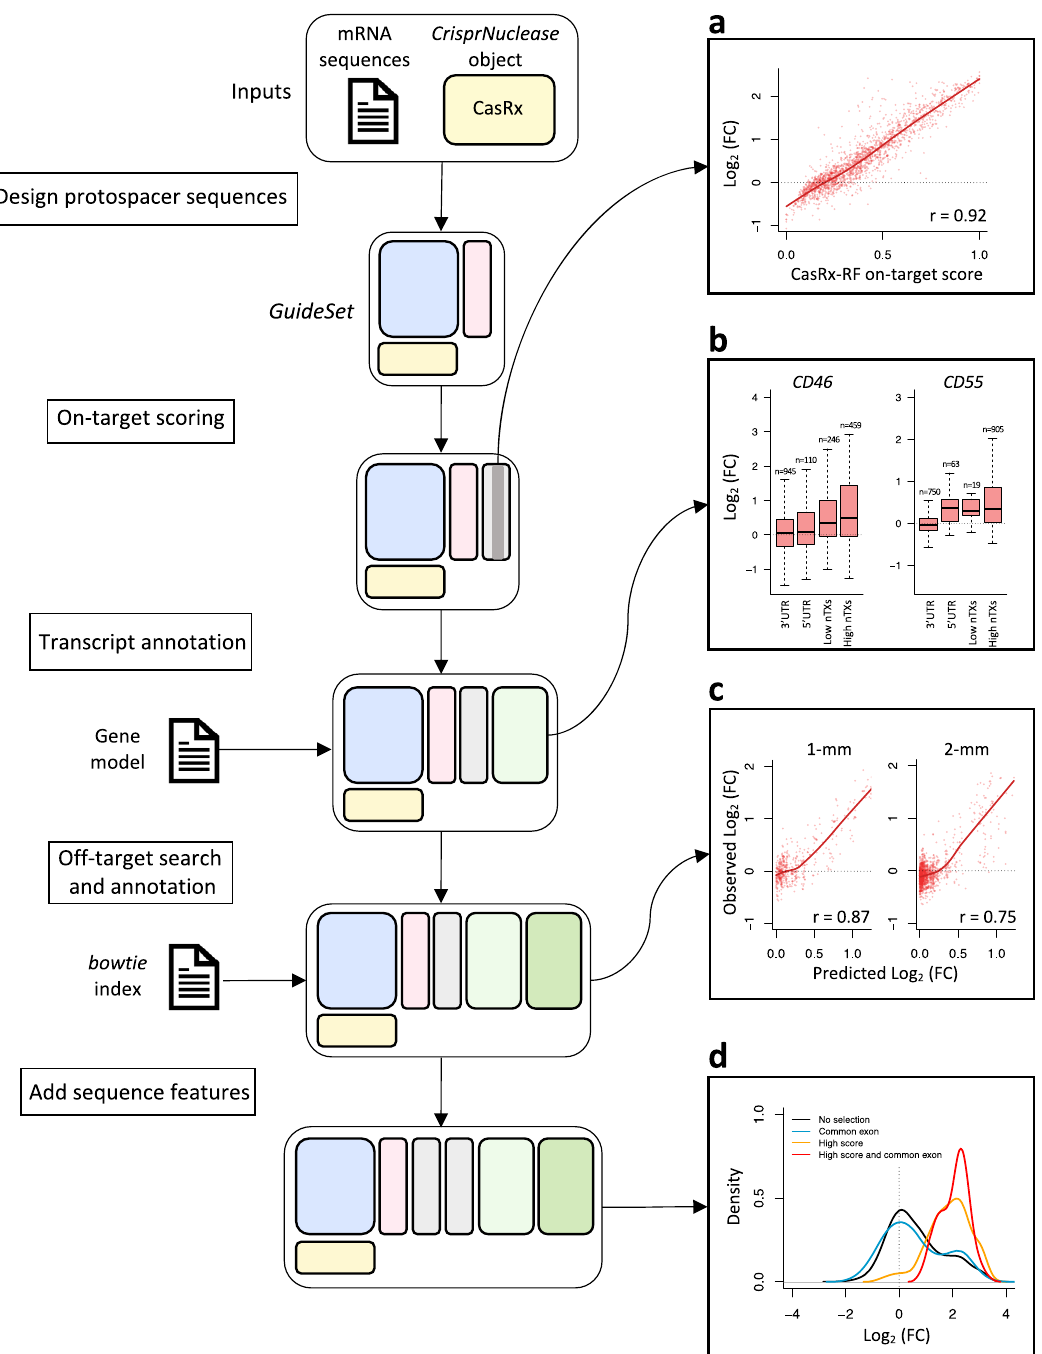
Fig. 5 | crisprDesign work fl ow to design gRNAs tiling CD55 and CD46 using CasRx. Ontheleft:schematicshowingthemajorstepsinvolvedindesigningCasRx gRNAstargeting CD55 and CD46 .Twoinputsarerequired:mRNAsequencesof CD55 and CD46 and a CrisprNuclease object from crisprBase . a Relationship between on- target CasRx-RF score calculated in crisprScore and LFCs from the pooled FACS tiling CasRx screening data (see Methods). A higher LFC indicates higher gRNA activity. b Relationship between LFCs from the CasRx screening data and gRNA context for CD46 and CD55 : gRNAs targeting 5 0 UTR and 3 0 UTR for the canonical transcript, and guidestargeting a lowand high number ofisoforms for each of the genes. gRNAs targeting more isoforms show higher enrichment in the screening